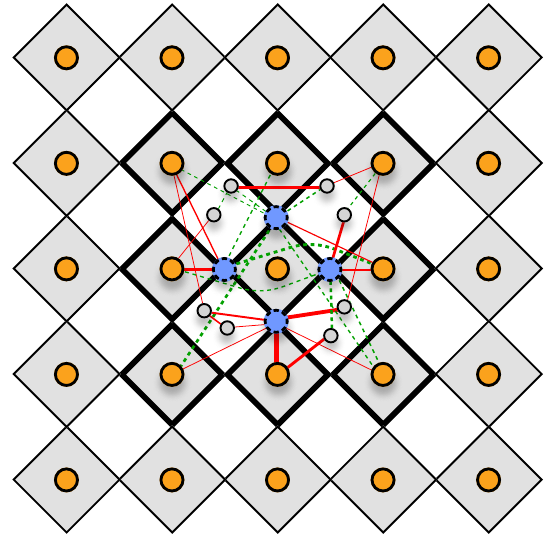
Figure 5: A neural network obtained from training at d = 3 (see Fig 7) can be used as a d = 5 decoder by inserting plaquette input nodes without connection weights linked to the rest of the neural